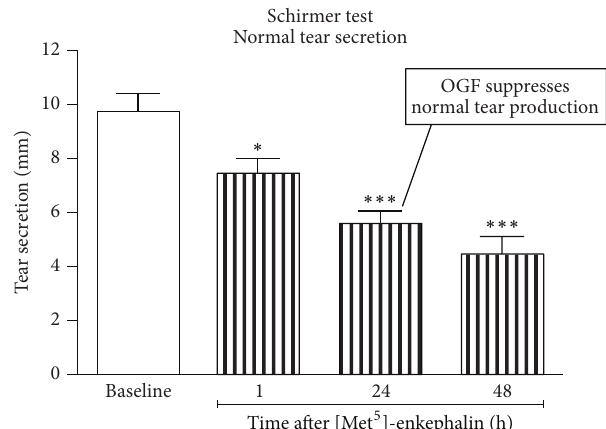
Figure 15: Impact of OGF treatment on tear secretion. One drop of 10 −5 M OGF, [ Met 5 ] -enkephalin, significantly reduces tear production in rats with initially normal levels. Values represent means ± SEM (derived from [62]). * refers to 𝑃 < 0.05 and *** refers to 𝑃 < 0.001 .